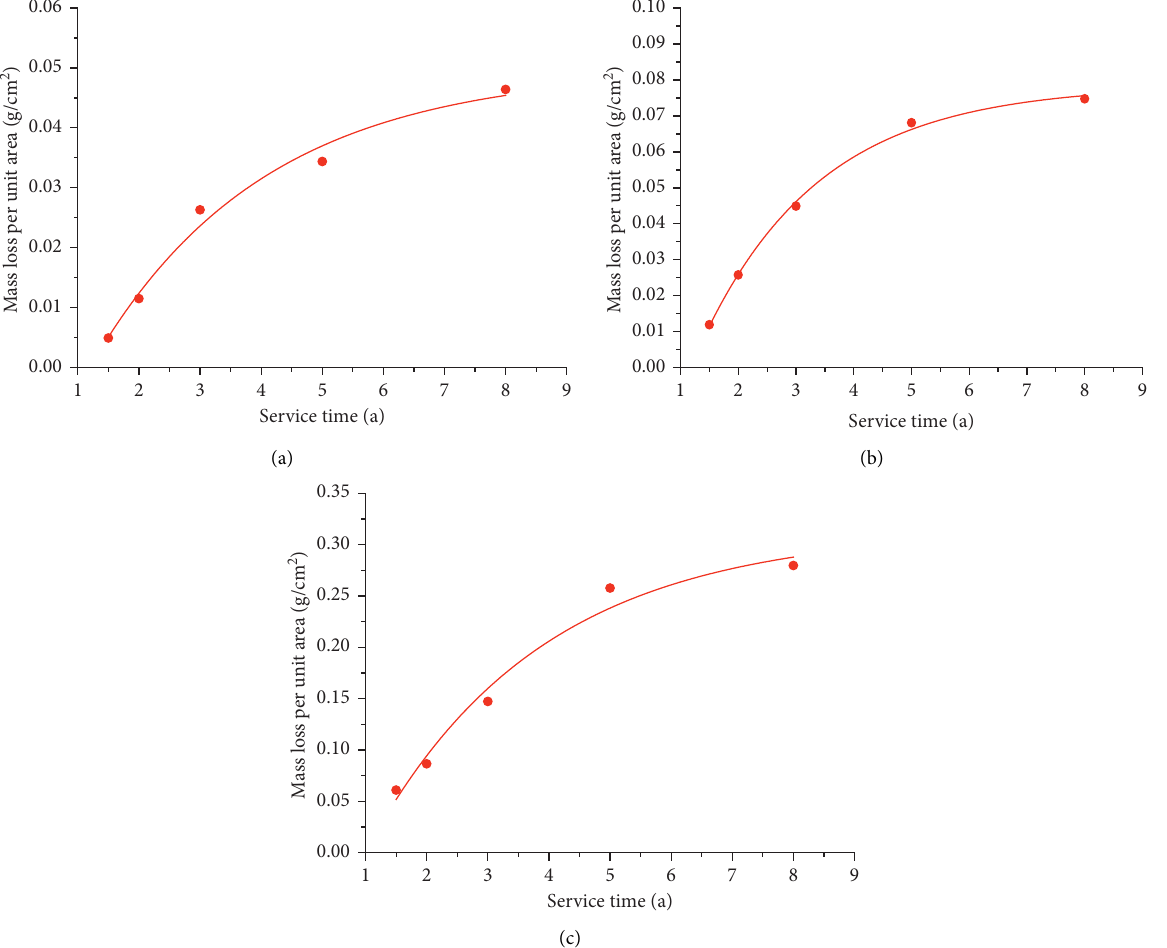
Figure 4: Time-mass loss relationship of different parts of the bolt. (a) Free section. (b) Anchor end. (c) Anchor